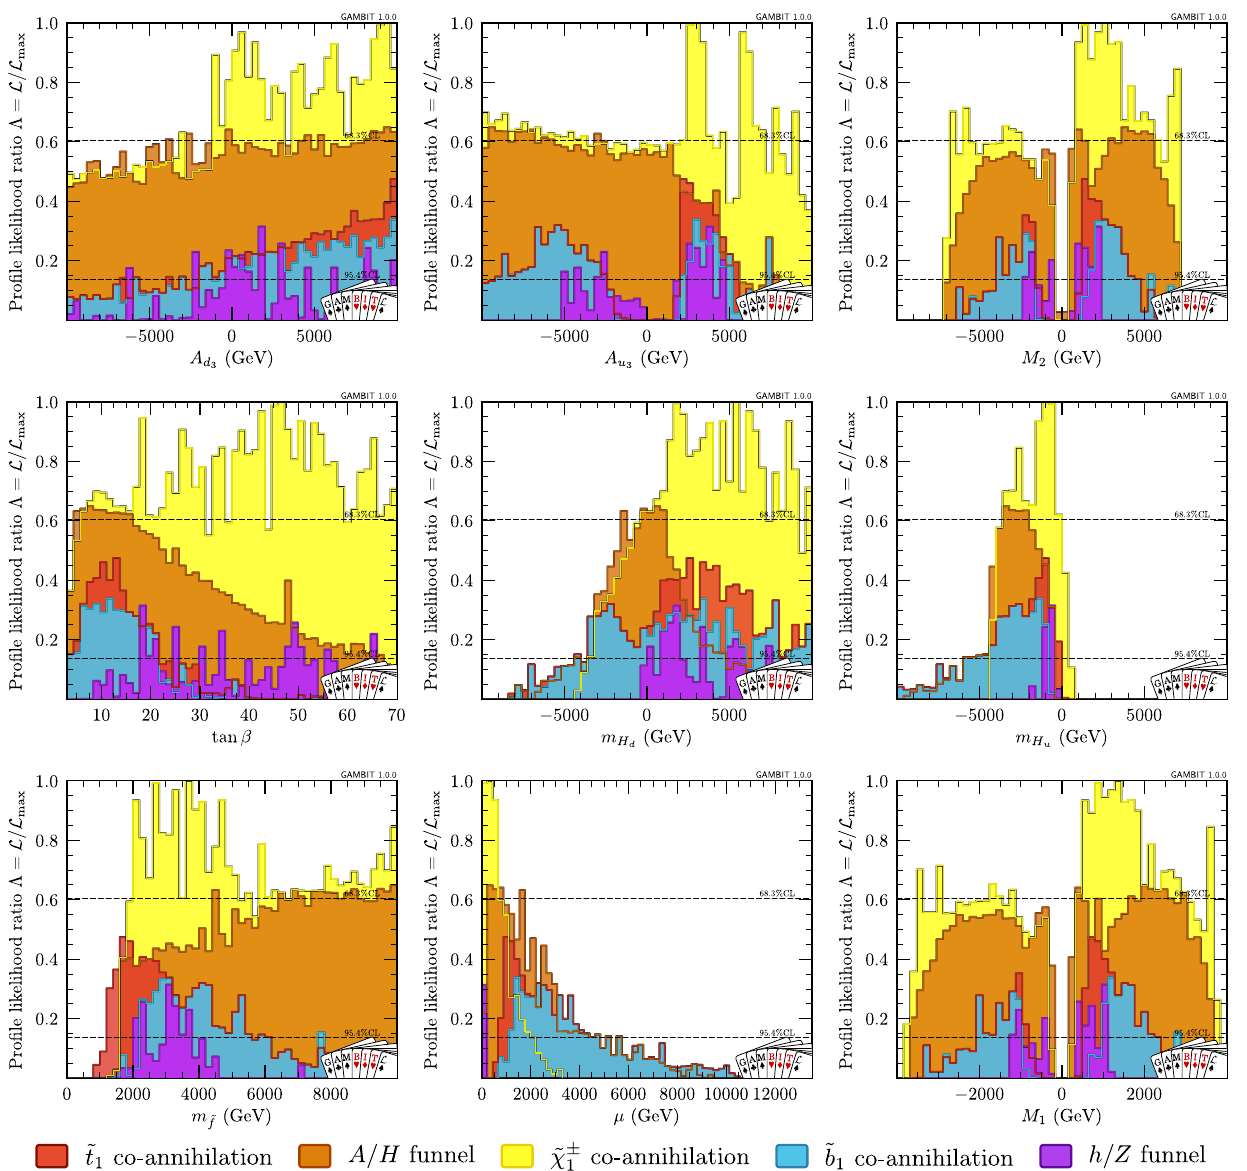
Fig. 2 1D profile likelihood ratio for the input parameters A d different sfermions are mostly generated by varying amounts of mixing. In comparison, the contribution from RGE run- ning from Q = 1 TeV to Q = M SUSY , which splits m 2 ˜ individual soft masses, is generally